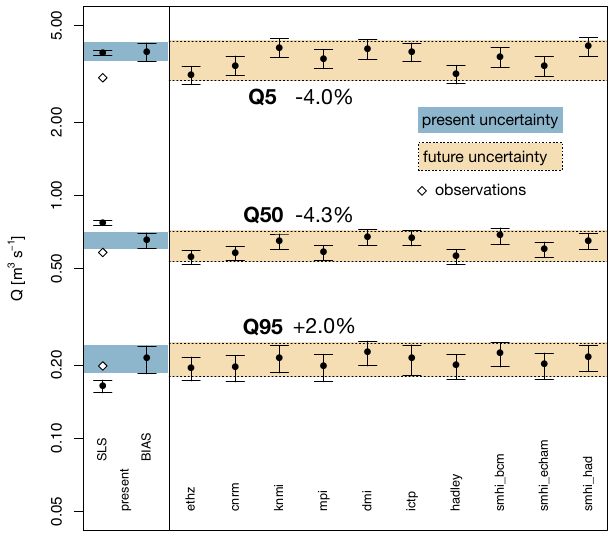
Figure 4. Modelled flow plotted against the observations in differ- ent workflow stages (Mönchaltorf, TS approach). Figure 5. Flow index predictions for Mönchaltorf with the TS ap- proach. Predictions for the present (left side) were made using gen- erated precipitation (stage 2). SLS: simple least squares calibration (for reference), BIAS: the Bayesian error model of TS. The right panel shows future predictions for the individual model chains. Fu- ture uncertainty is the joint prediction from all 10 model